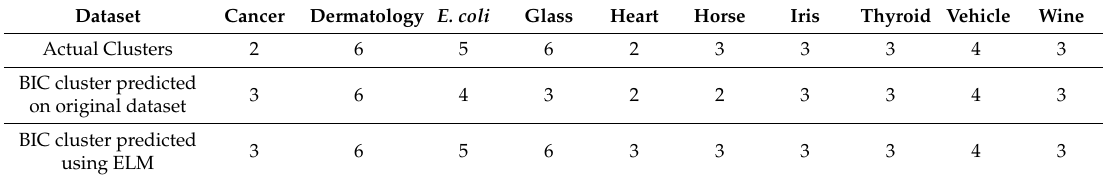
Table 2. Cluster predicted using BIC for actual data and ELM-based feature learning